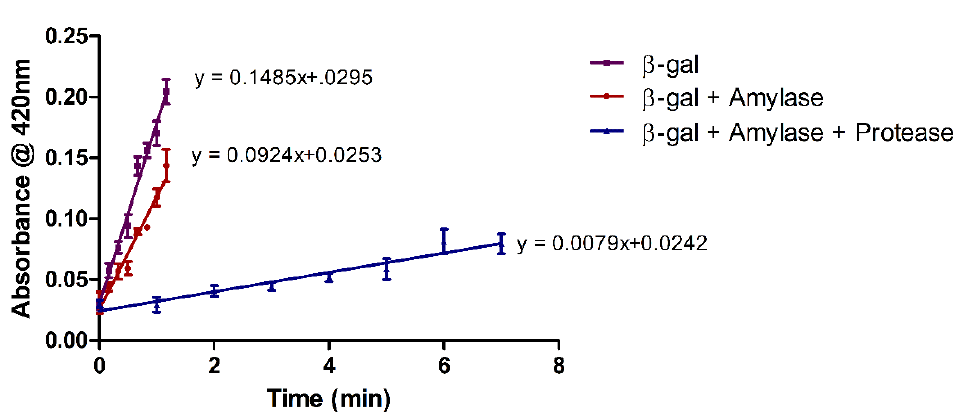
Figure 2. Activity progress curves for β -gal immobilized individually on an SMA nanofibrous mat, and in combination with α -amylase, as well as a combination of α -amylase and protease. Activity was spectrophotometrically determined as a function of time using ONPG as substrate. All results are shown as the mean ± SD of triplicate experiments (n = 3).